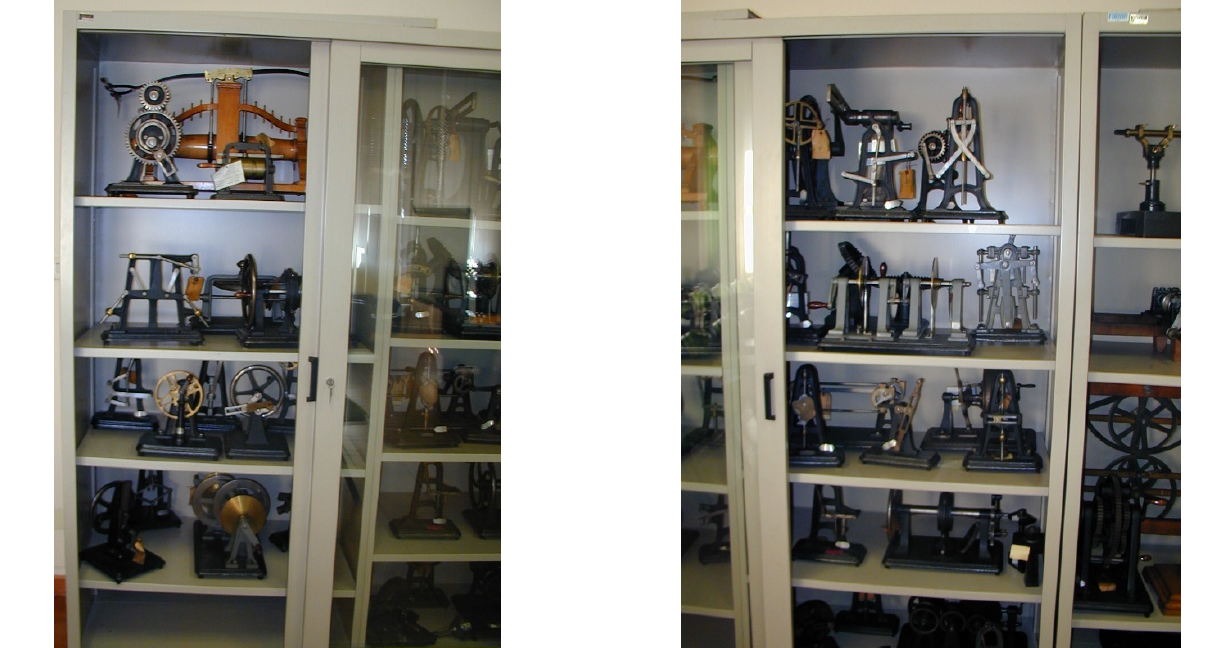
Figure 15. The collection of models of mechanisms at the Department of Mechanical and Aerospace Engineering at the Polytechnic of Turin.